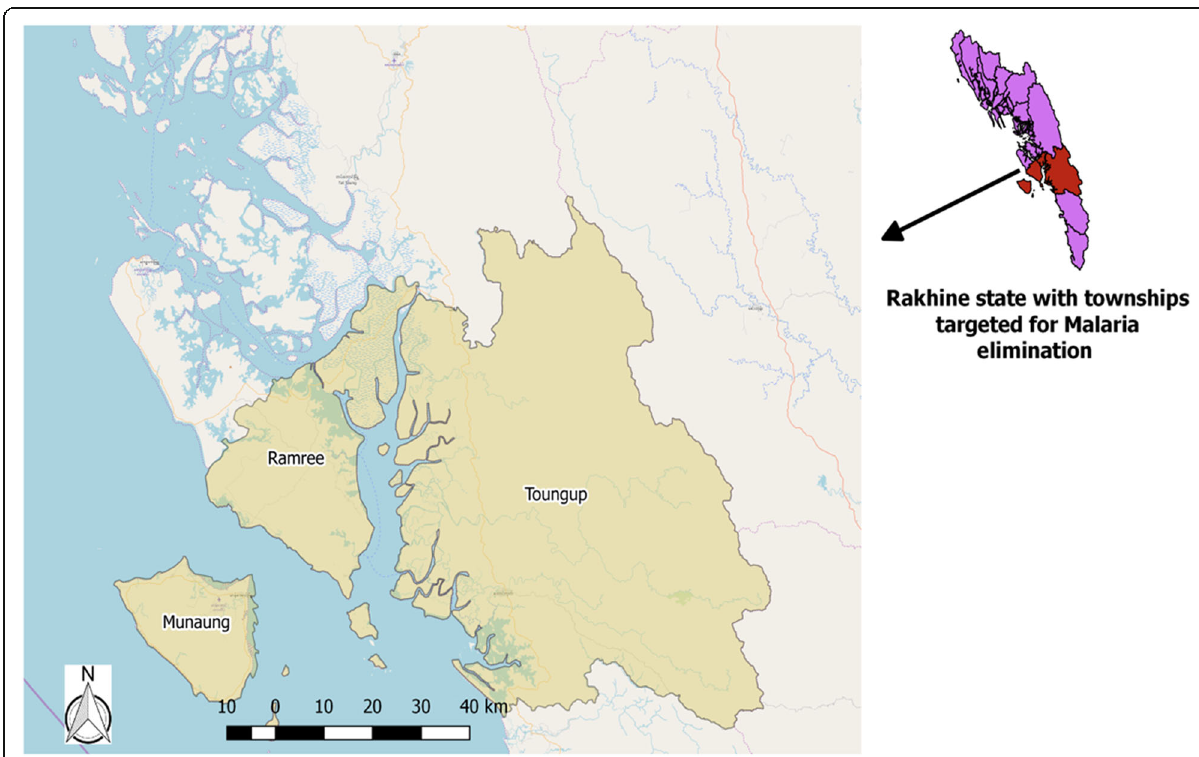
Fig. 1 Map of Myanmar with study areas (townships targeted for malaria elimination in Rakhine